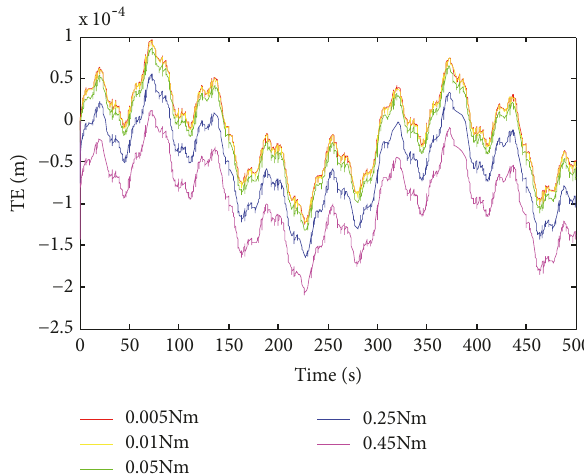
Figure 9: LTE curves under different torques.